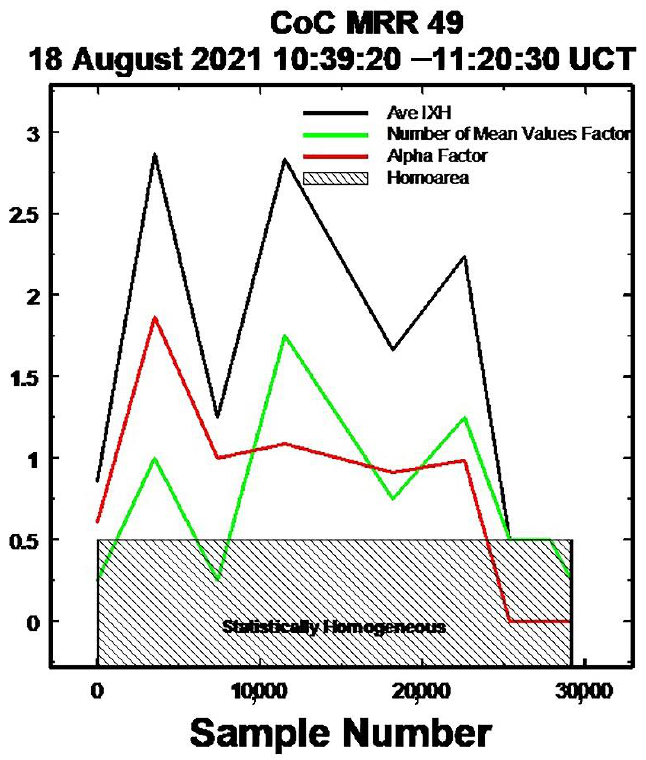
Figure 3. Plots of the IXH averaged over the temporal and height vector series for each of the grey areas in Figure 2 placed at the mid-points of each region. Only at the right-most part of the figure is there any sign of statistical